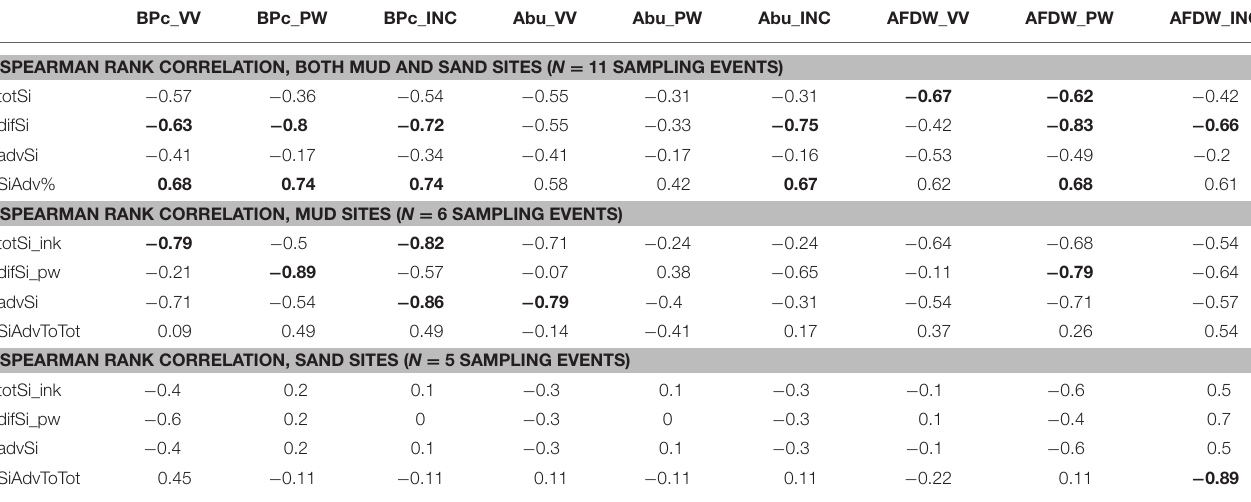
TABLE 4 | Spearman rank correlation coefficients between the estimated total, diffusive, and advective fluxes, as well as advective component of Si, and general macrofaunal parameters (averaged per cruise and site). BPc_VV BPc_PW BPc_INC Abu_VV Abu_PW